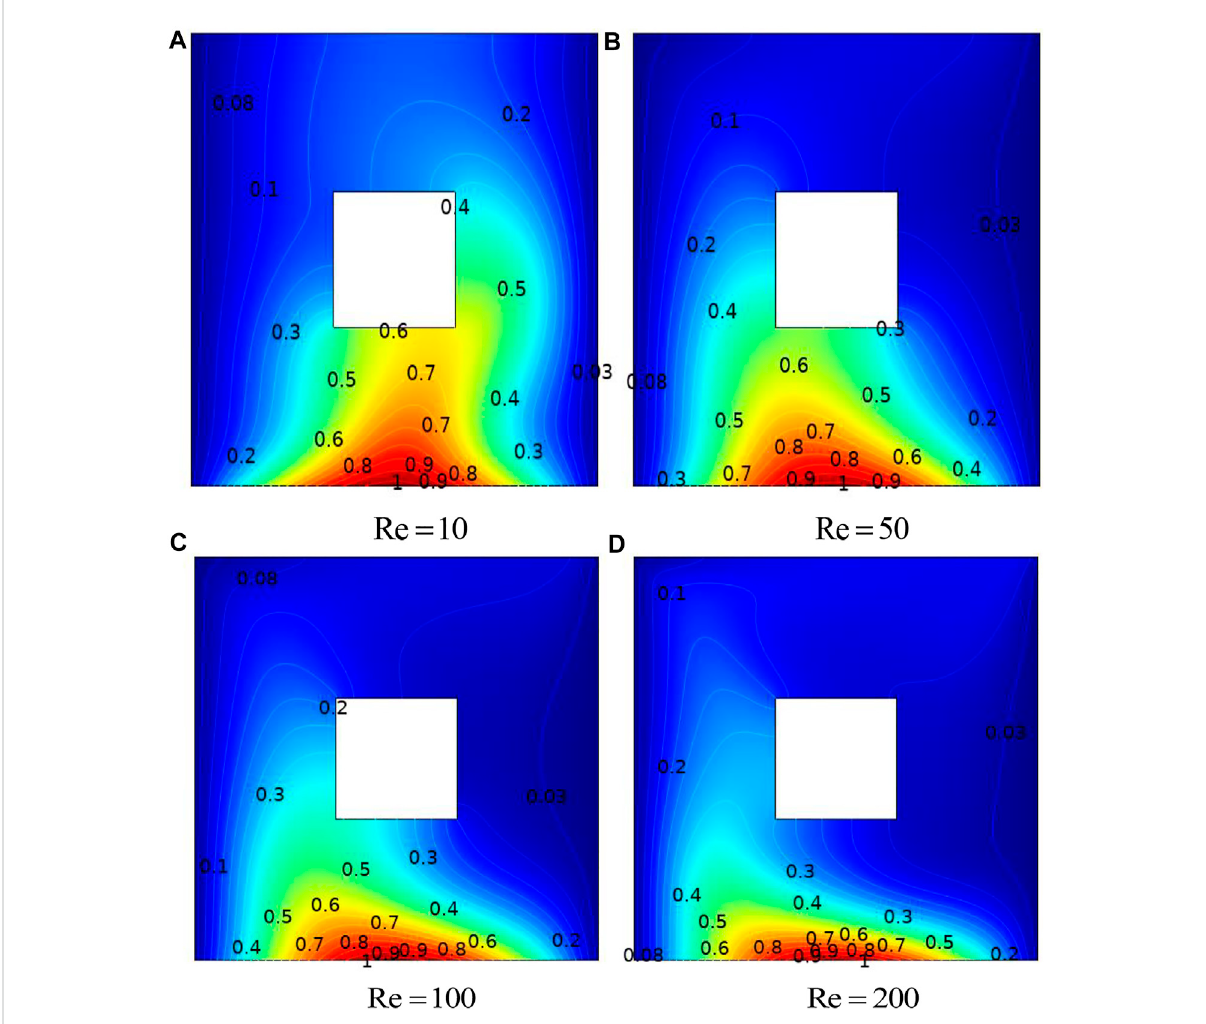
FIGURE 10 In fl uence of Re on streamlines with a non-uniformly heated bottom wall: adiabatic cylinder with Ha (cid:2) 20and Gr (cid:2) 10 4